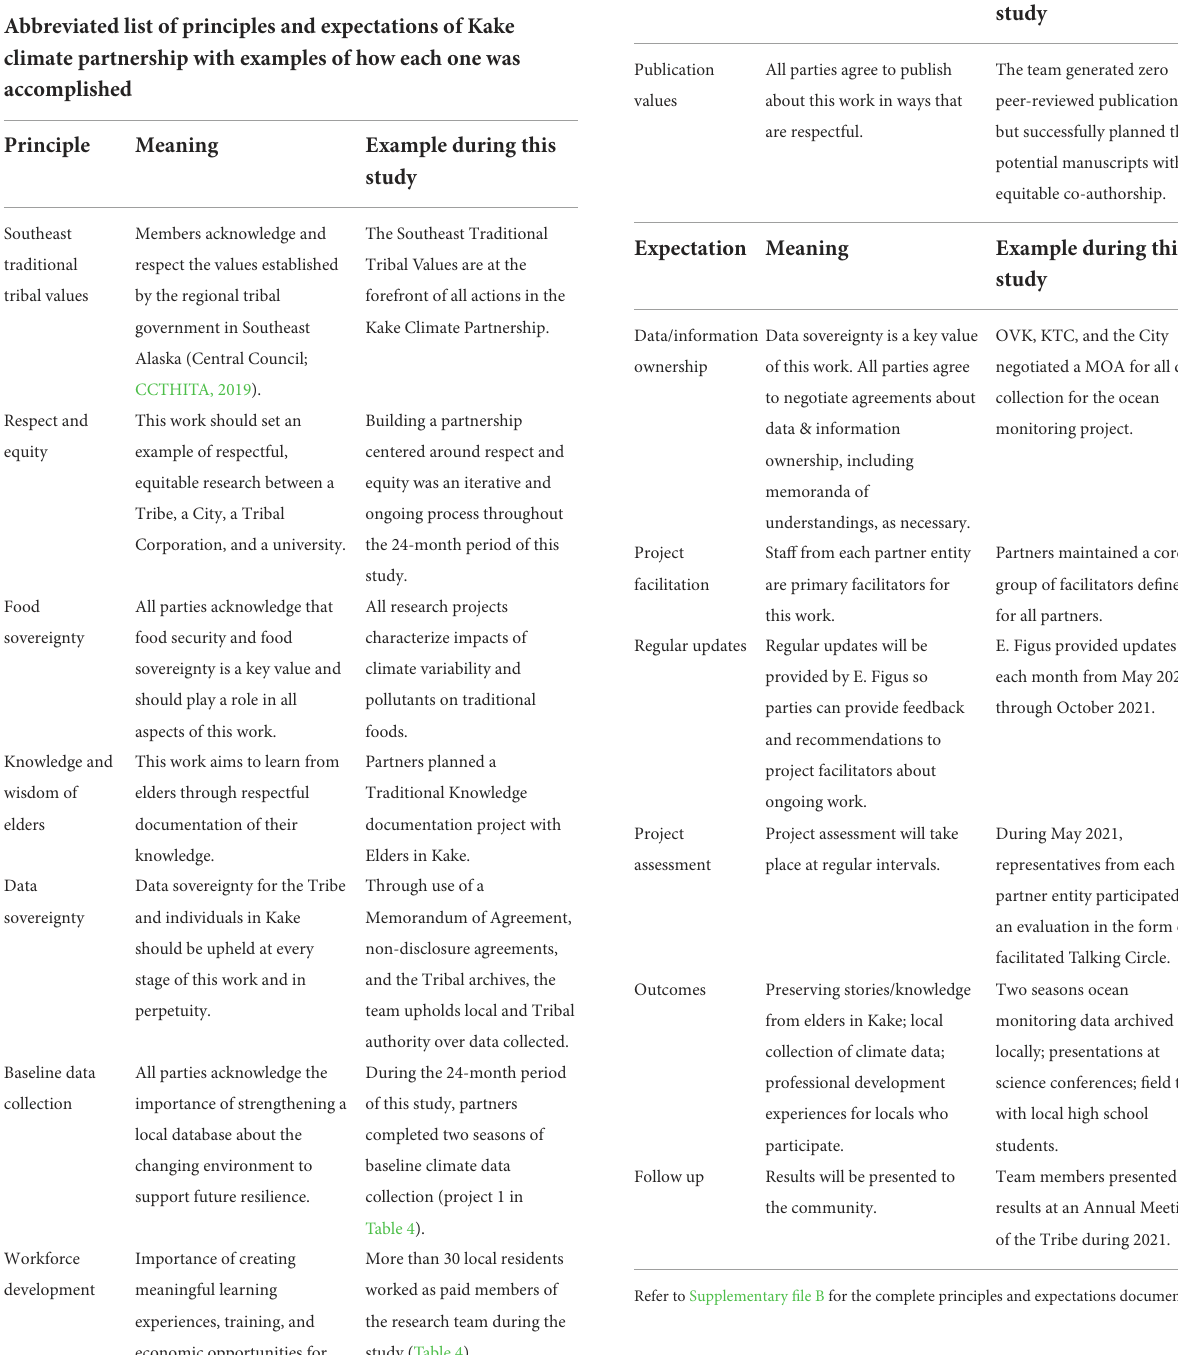
TABLE 3 Abbreviated list of principles and expectations of kake llimate partnership with examples of how each one was accomplished during the 24-month period of this